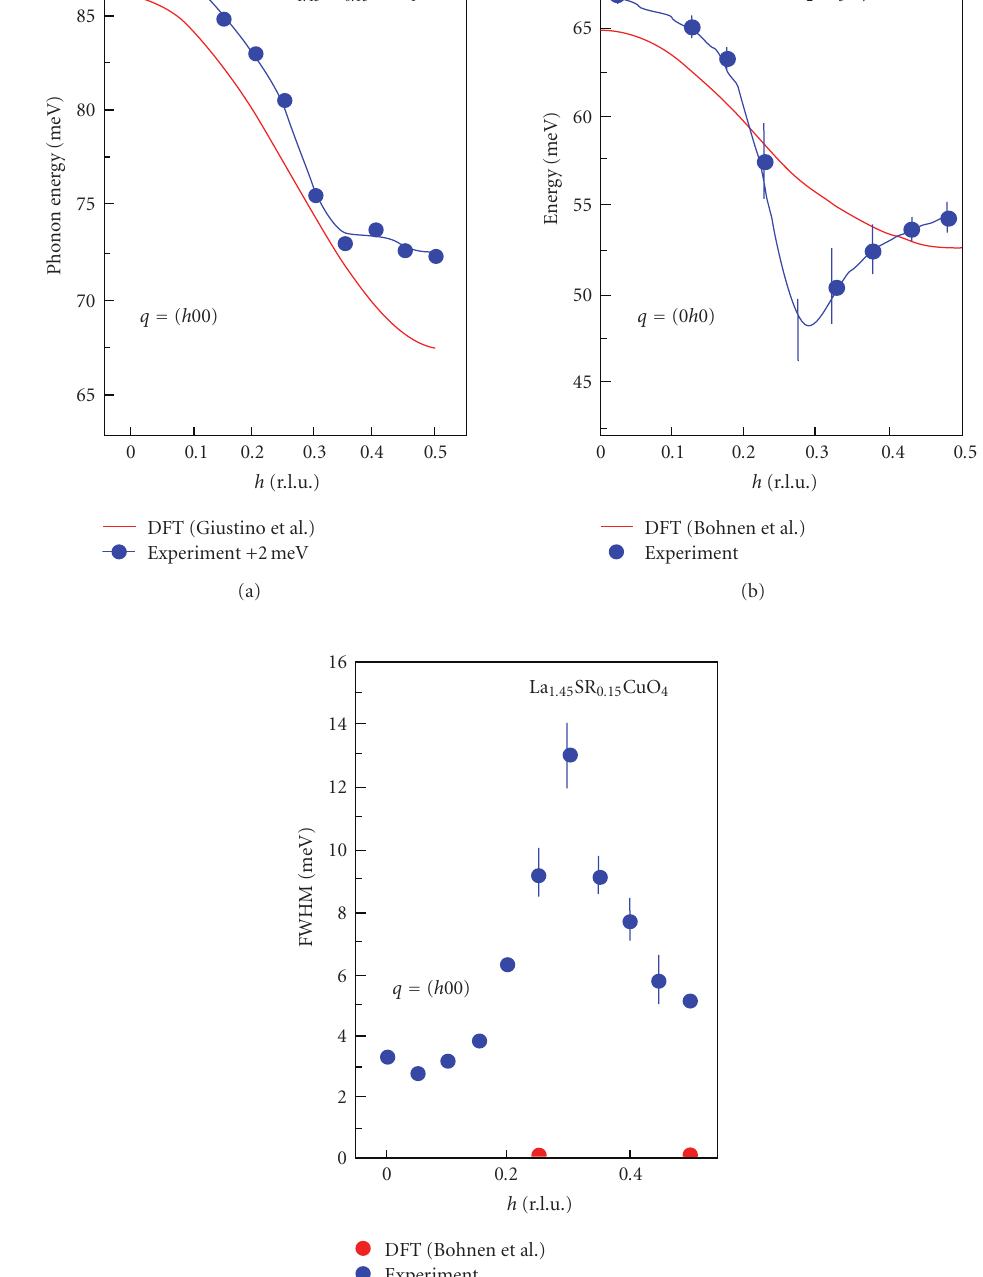
(O dominated mode in the CuO 2 planes) show pronounced asymmetry which is absent in YBa 2 Cu 3 O 6 . This asymmetry means that there is an appreciable interaction of Raman active phonons with continuum states